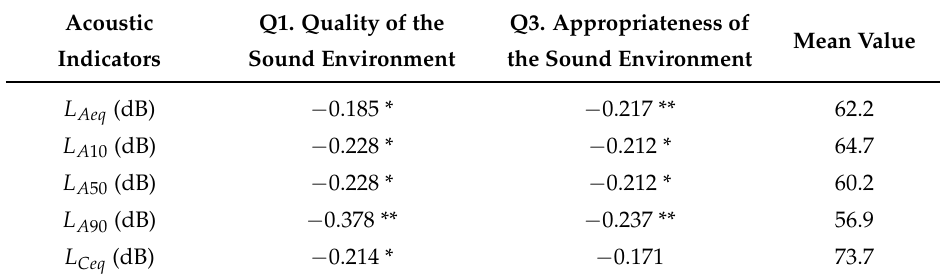
Table 3. Spearman correlation between acoustic indicators and the sound environment assessment (** correlation is significant at the 0.01 level; * correlation is significant at the 0.05 level). The mean values of acoustic indicators are